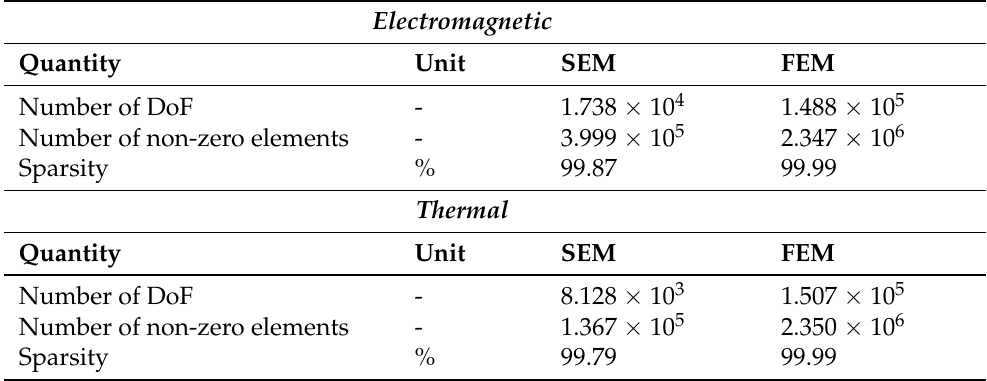
Table 3. Computational effort of both the electromagnetic and thermal model of the benchmark system for both the SEM and